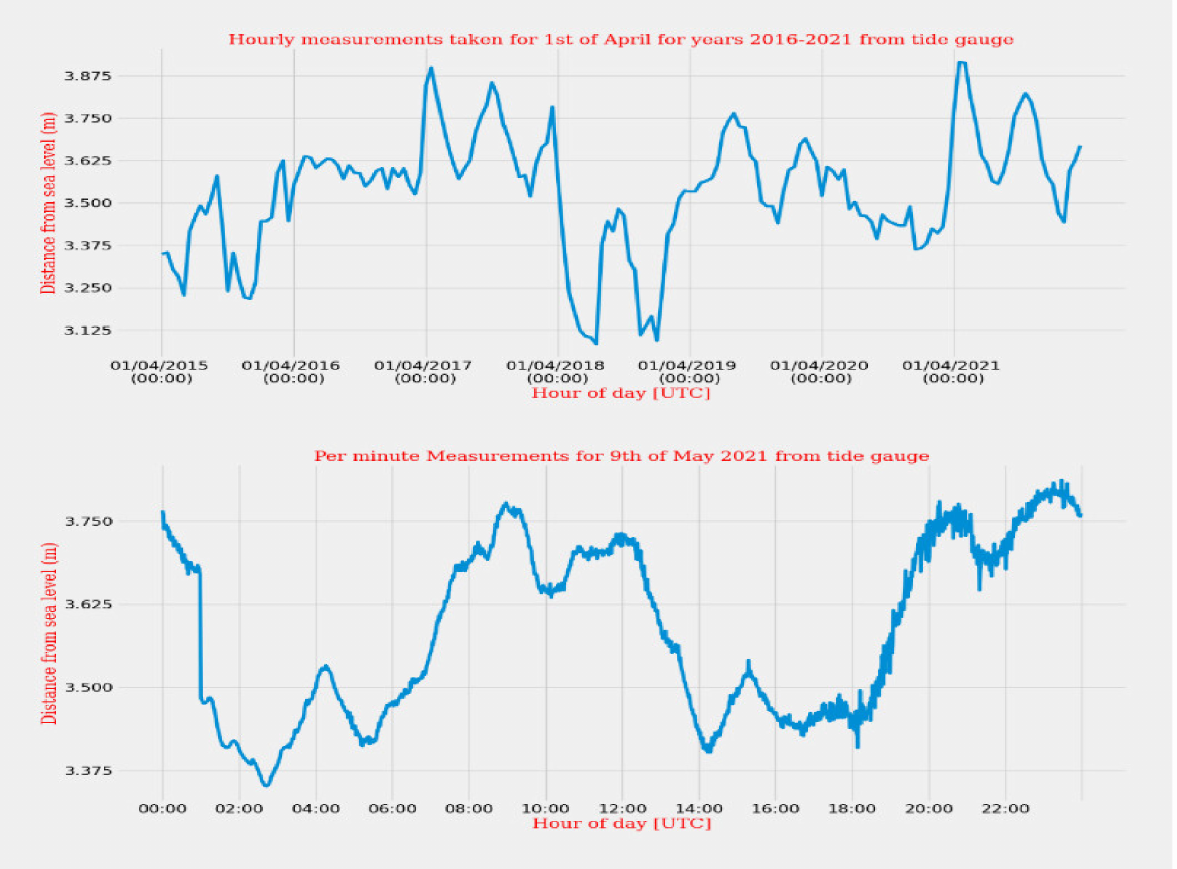
Figure 19. Real-Time tide gauge